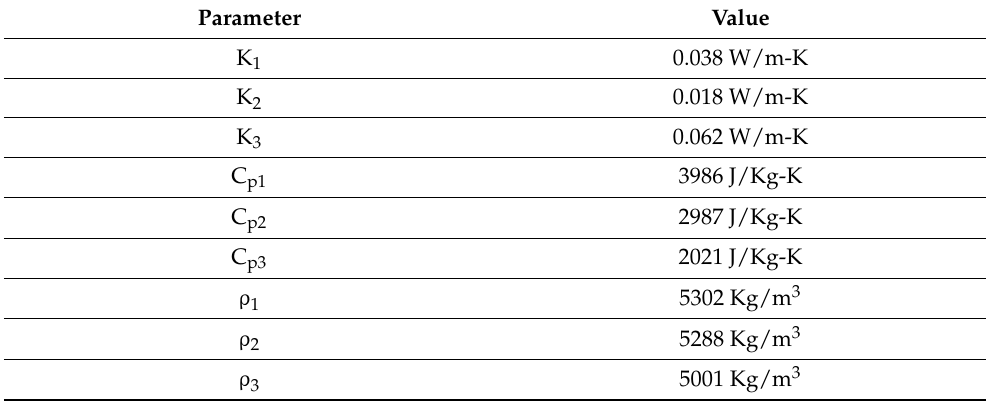
Table 7. 2D Thermal Model Parameter Values for Battery at 3 Experimental SOHs 65%, 85% and 91% in